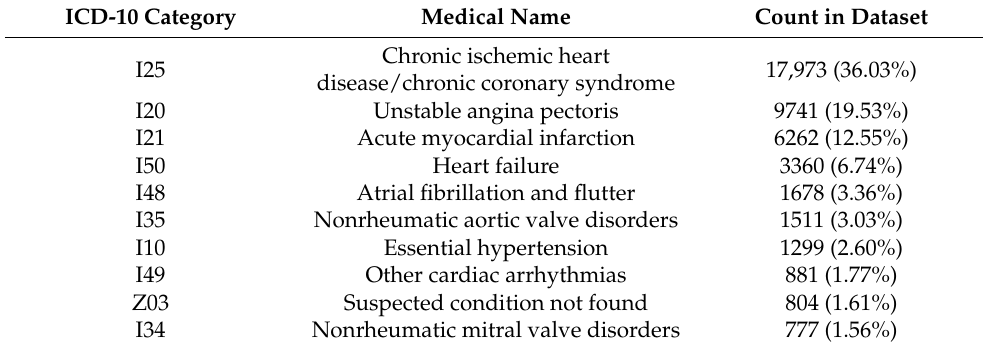
Table 4. Overview of the training subsets listing individual ICD-10 categories included in the train- ing and coverage of such a subset with respect to the whole dataset.